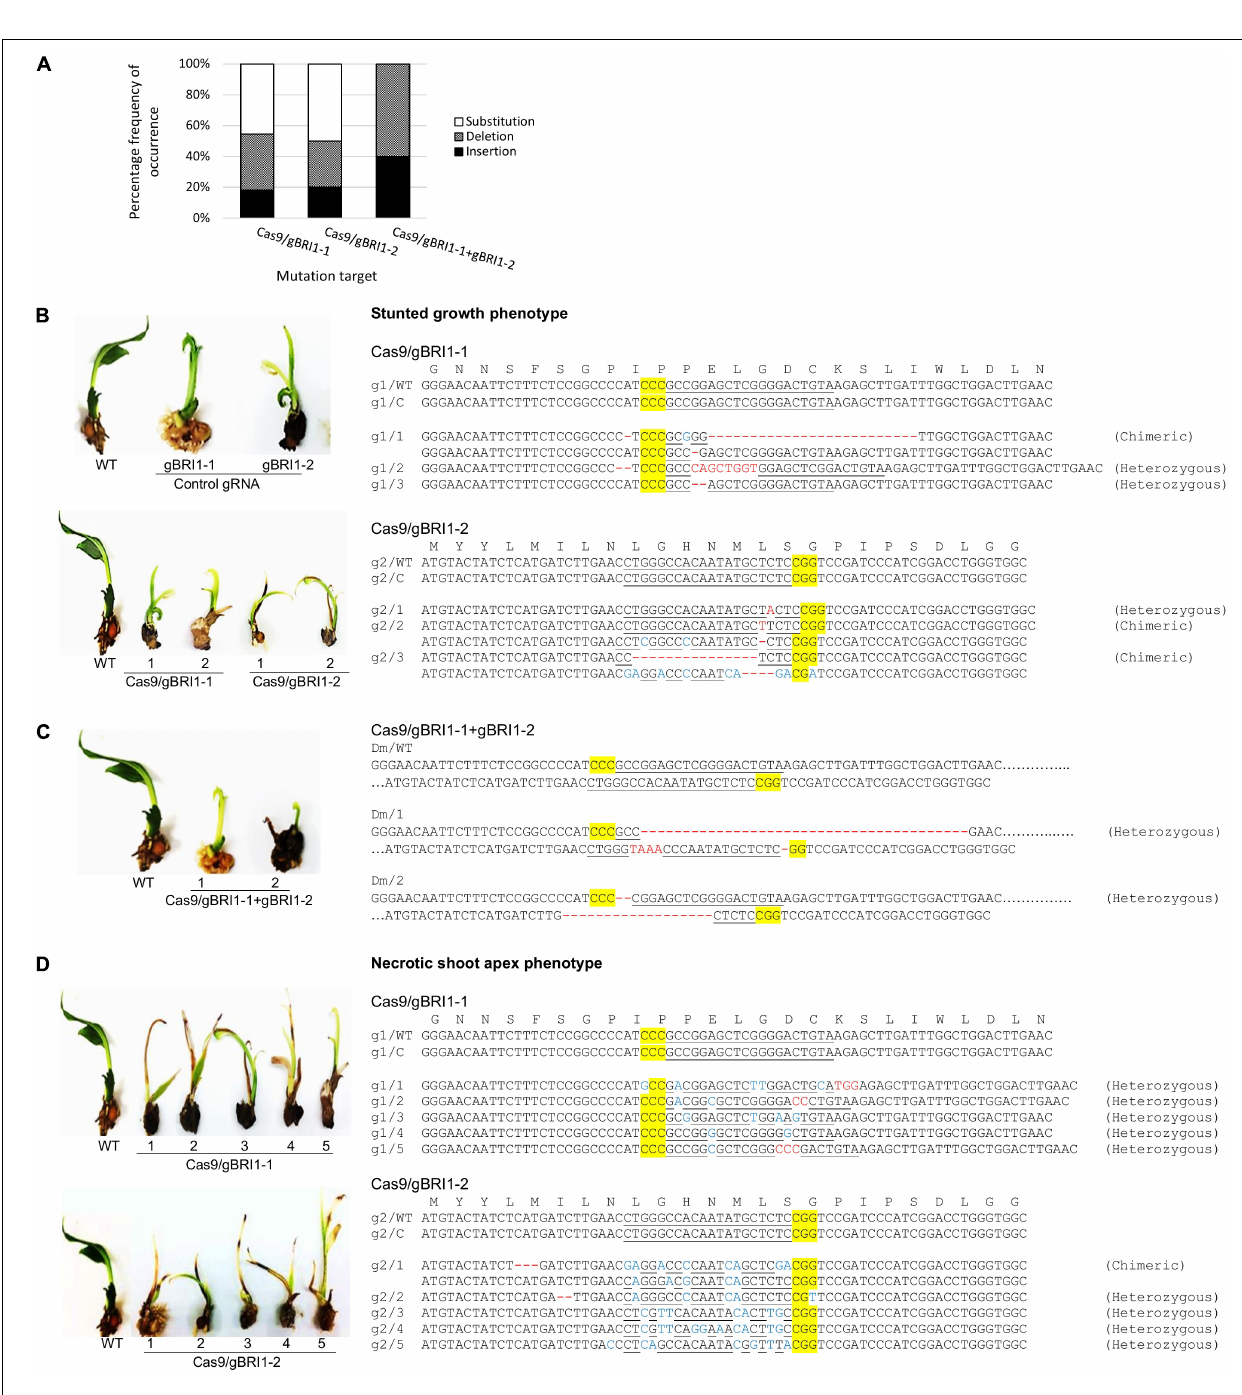
FIGURE 5 | Clustered regularly interspaced short palindromic repeat/Cas9-mediated mutation events and phenotypes of EgBRI1 mutant transgenic oil palm. (A) The overall percentage frequency of occurrence for each type of mutation event detected at gBRI1-1 and gBRI1-2 targeted sites. The mutation events detected in the transgenic oil palms exhibiting (B) stunted growth phenotype induced by CRISPR/Cas9 and gBRI1-1, gBRI1-2, or (C) dual gRNAs mutation induction in the EgBRI1 gene, and (D) necrotic shoot apex phenotype. PAM is highlighted in yellow, InDels sequences of the target site are shown in red, and nucleotide substitution is marked in blue. g1, gBRI1-1; g2, gBRI1-2; WT, wild-type; C, control; Dm, double mutant; 1–5, plantlet